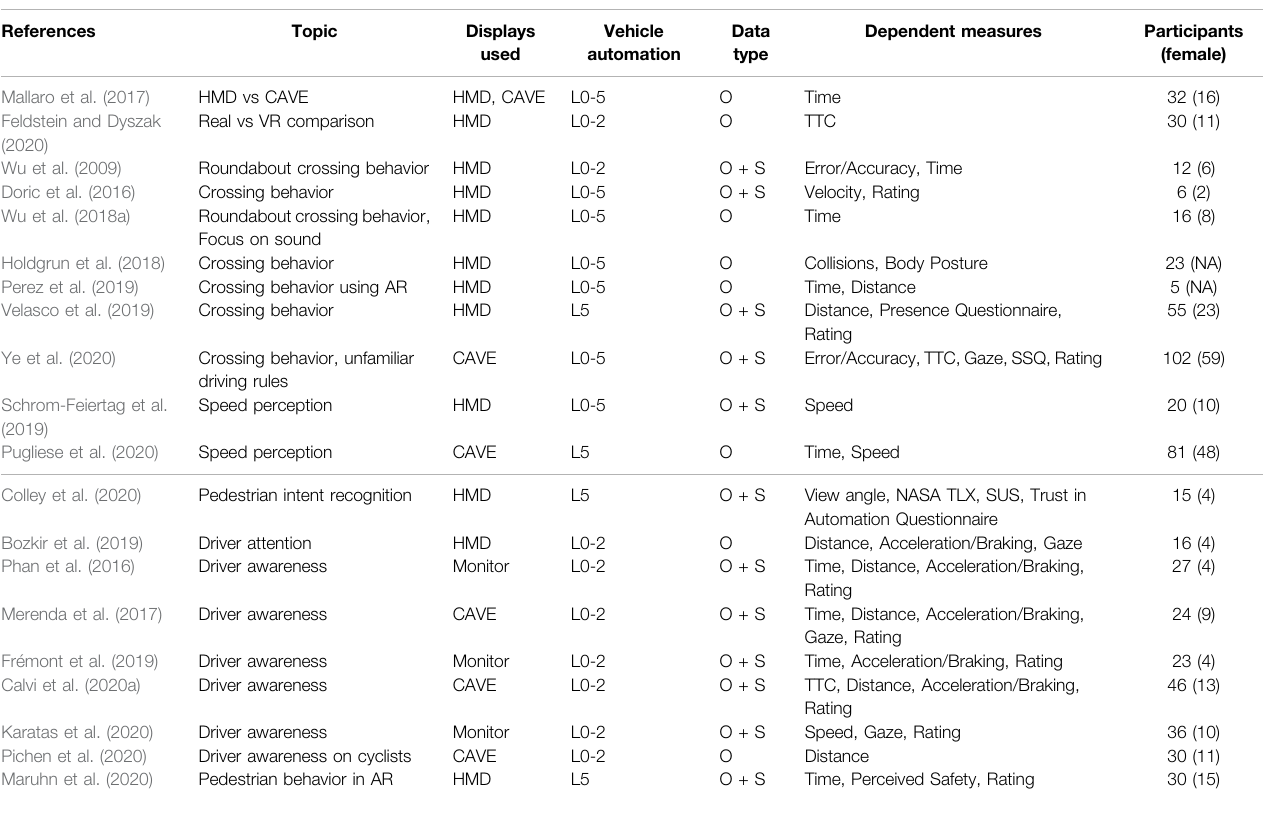
TABLE 13 | Summary of user studies in Vulnerable Road Users application